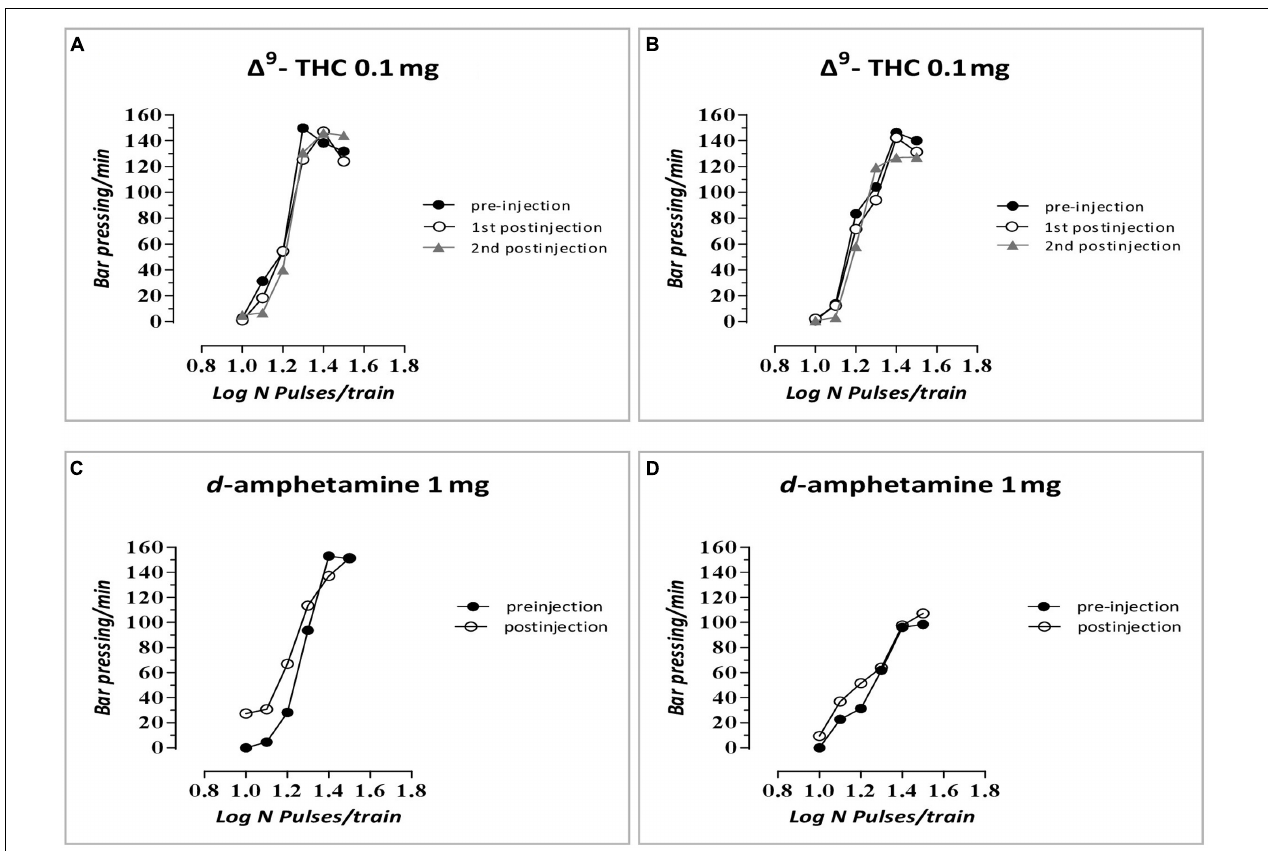
FIGURE 6 | Rate-frequency functions (rate of lever pressing as a function of stimulation frequency) taken from representative F1 animals. Each plot represents data from a single animal under predrug and drug conditions. Rate frequency functions were obtained by logarithmically decreasing the frequency of the stimulation pulses from a value that sustained maximal lever pressing to one that failed to sustain lever pressing. (A) Mother treatment (cid:49) 9 -THC 0.1 mg/F1 animal treatment (cid:49) 9 -THC 0.1 mg, (B) mother treatment (cid:49) 9 -THC 1 mg/F1 animal treatment (cid:49) 9 -THC 0.1 mg, (C) mother treatment (cid:49) 9 -THC 0.1 mg/F1 animal treatment d -amphetamine 1 mg, and (D) mother treatment (cid:49) 9 -THC 1 mg/F1 animal treatment d -amphetamine 1